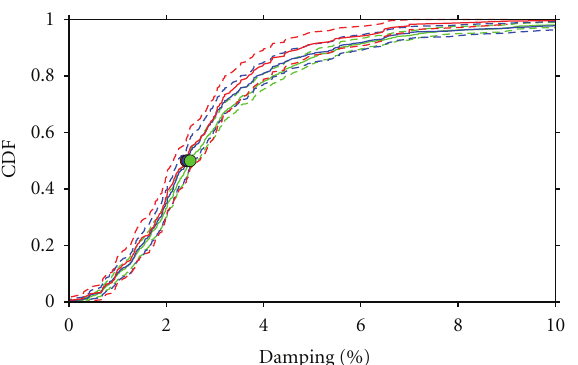
Figure 11: Comparison of CDFs of damping derived for the fundamental mode on the longitudinal component considering di ff erent recording lengths, that is, 30 (cid:3) (red), 60 (cid:3) (blue), and 120 (cid:3) (green).